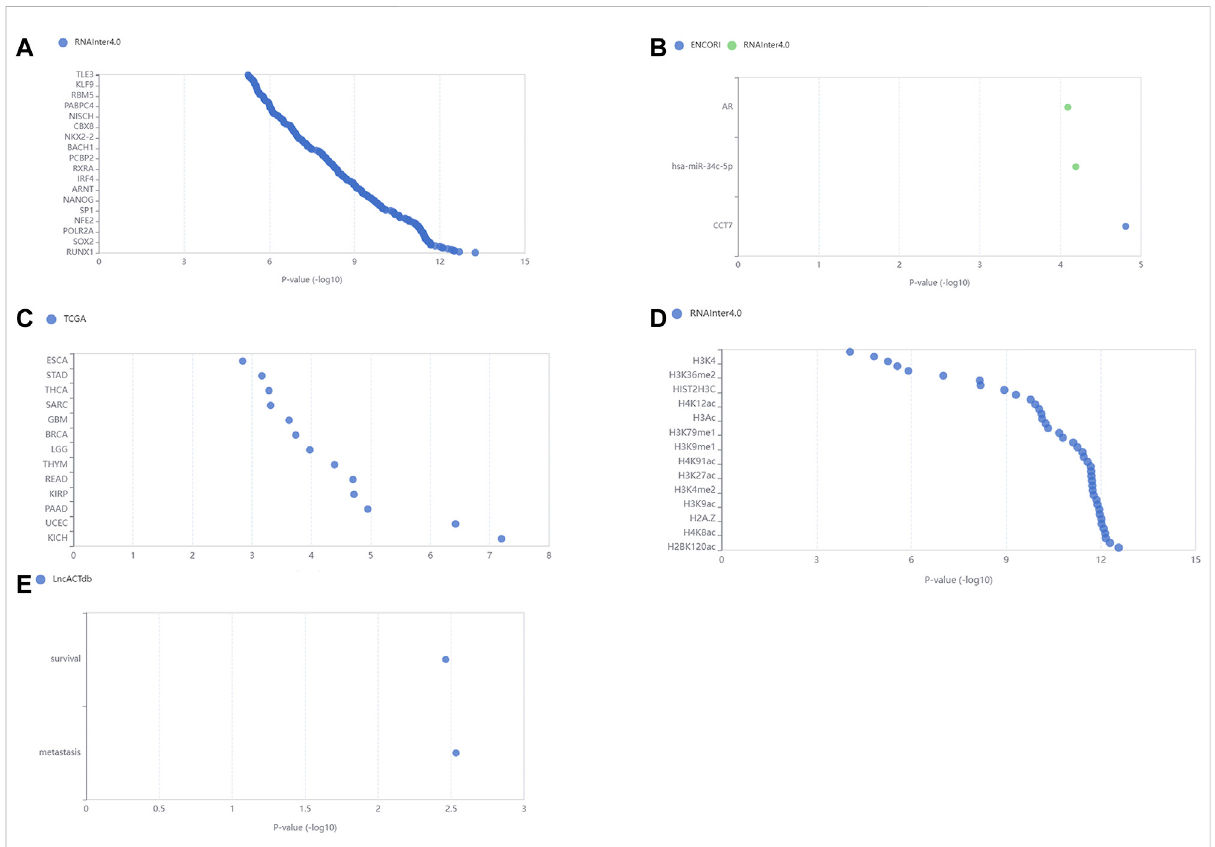
FIGURE 4 LncSEA platform annotation analysis results. These lncRNAs are closely associated with (A) RNA Protein interaction; (B) RNA interaction; (C) survival; (D) RNA Histone modi fi cation; (E) Cancer functional state.